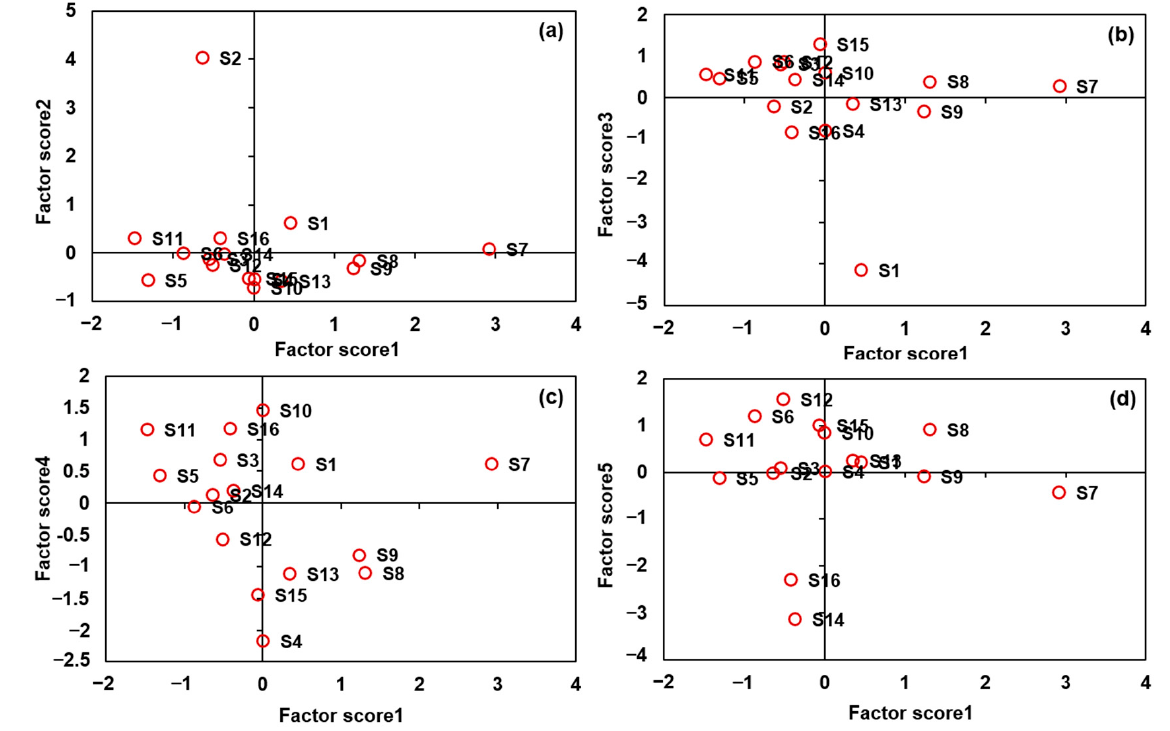
Figure 8. Factor scores for water quality monitoring stations in Tianjin. S1–S16 are water quality monitoring stations 1–16, respectively.